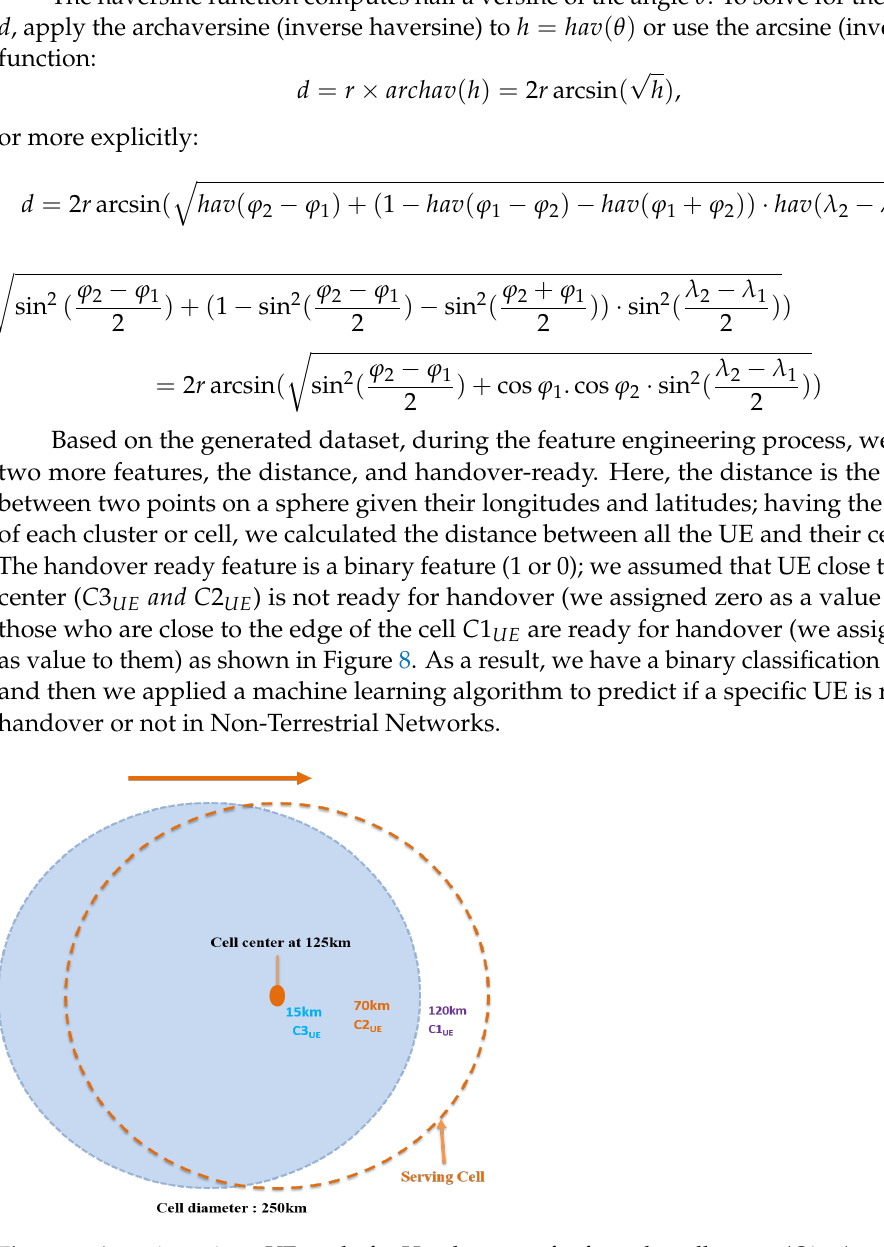
Figure 8. At a given time: UE ready for Handover are far from the cell center ( C 1 UE ), and UE not ready for Handover are close to the cell center ( C 3 UE and C 2 UE